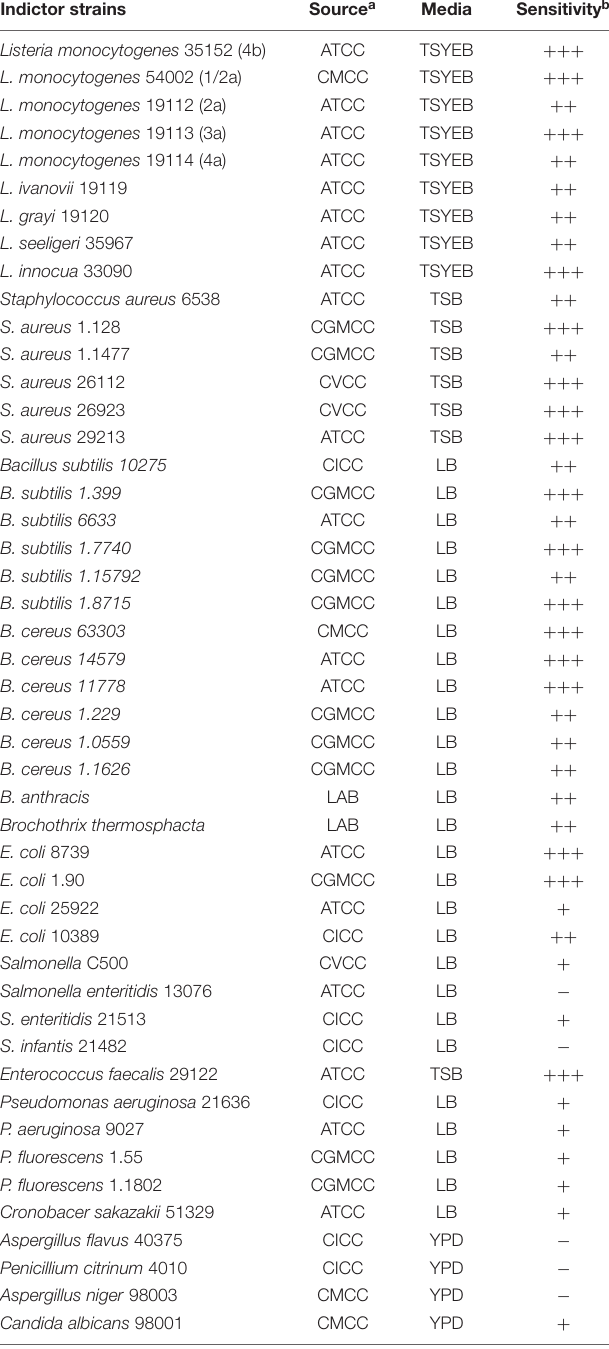
TABLE 1 | Antimicrobial spectrum of enterocin